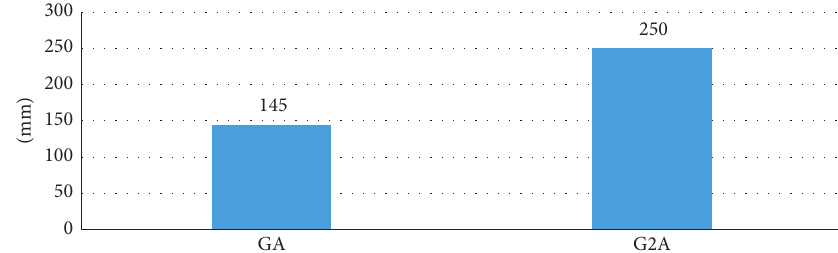
Figure 2: Influence of the change in concentration of sodium silicate on the flowability of